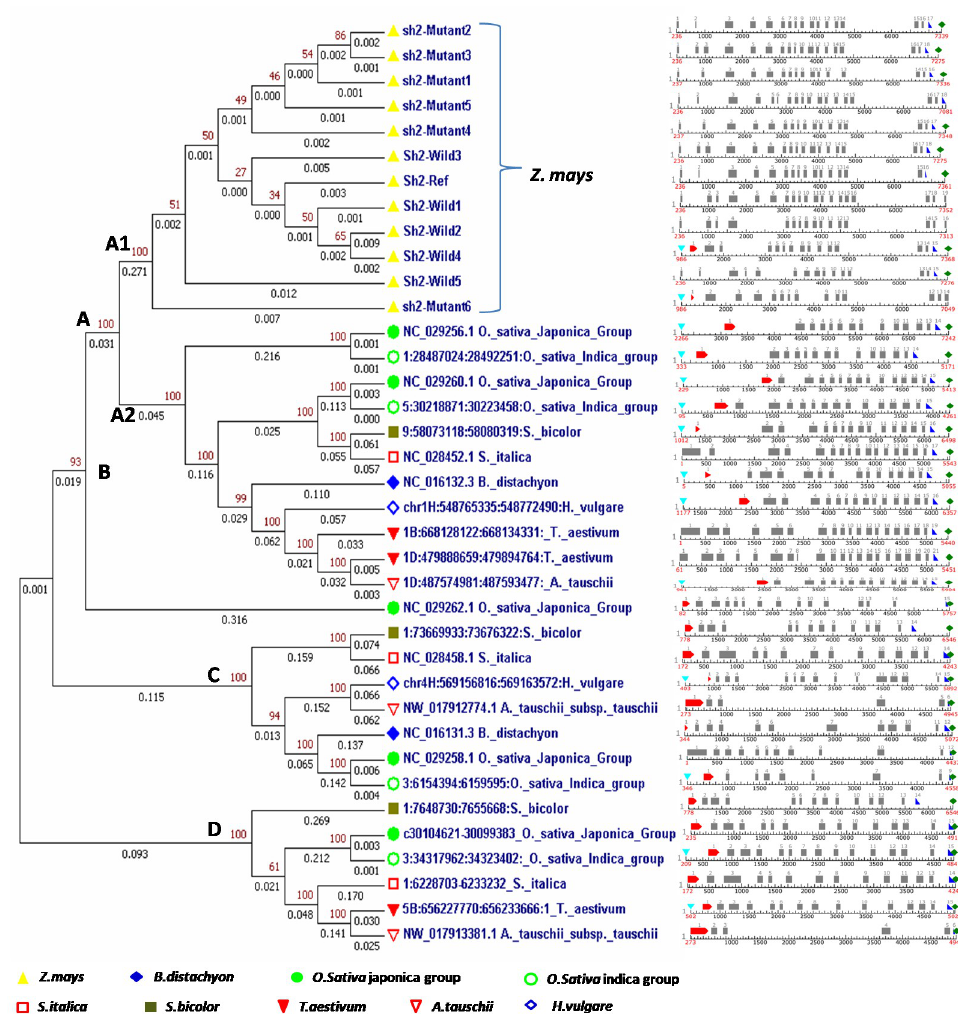
Fig 5. Evolutionary relationship of Sh2 gene in maize and its orthologues in selected monocots with their gene architecture.